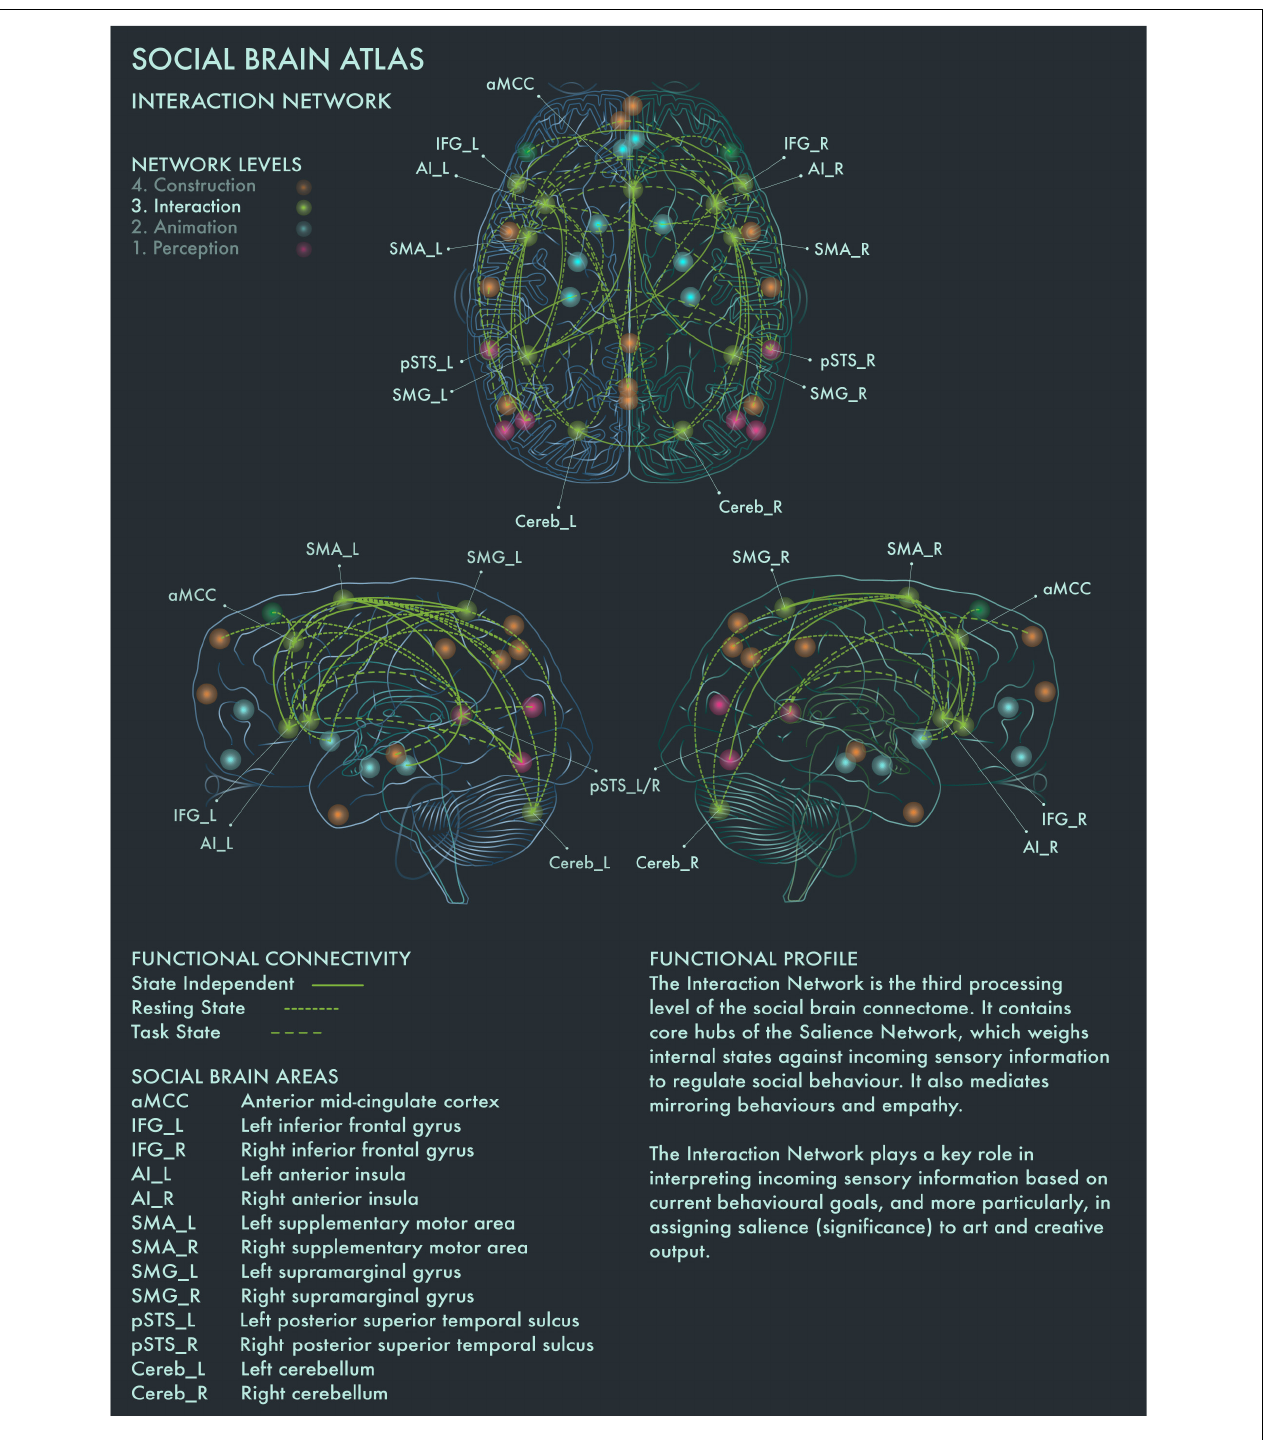
FIGURE 3 | Social Brain Atlas Level 3: Interaction Network. This figure shows the functional connectivity patterns of the Interaction Network (IN), based on data derived from Alcalá-López et al. (2017) (see also Table 1(C) ). Graphical conventions are the same as Figure 1 . The core nodes of the IN have been labeled as follows: Anterior mid-cingulate cortex (aMCC); Bilateral inferior frontal gyrus (IFG_L/R); Bilateral interior insula (AI_L/R); Bilateral supplementary motor area (SMA_L/R); Bilateral supramarginal gyrus (SMG_L/R; Bilateral posterior superior temporal sulcus (pSTS_L/R); Bilateral cerebellum (Cereb_L/R). The IN is the third processing level of the social brain connectome. It contains core hubs of the Salience Network, which weighs internal states against incoming sensory information to regulate social behavior. It also mediates mirroring behaviors and empathy. The IN plays a key role in interpreting incoming sensory information based on current behavioral goals, and more particularly, in assigning salience (significance) to art and creative